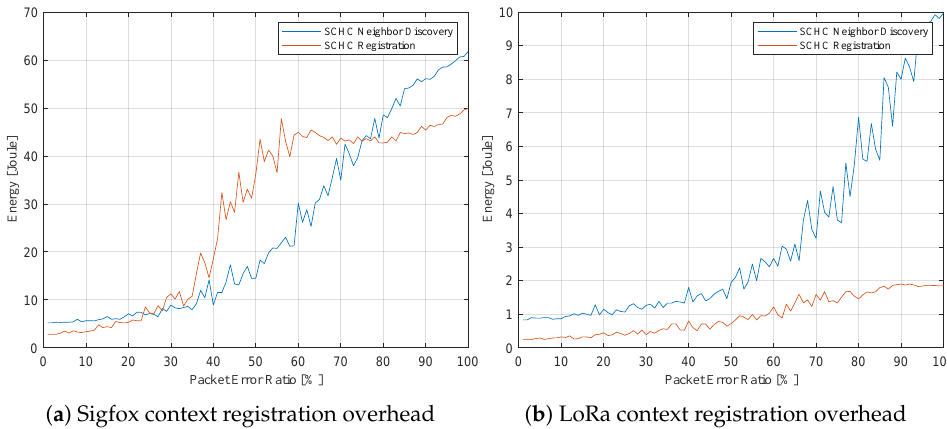
Figure 16. Energy overhead in order to configure the SCHC context for different PERs. From these graphs we can conclude that devices should increase their back-off pe- to decrease.